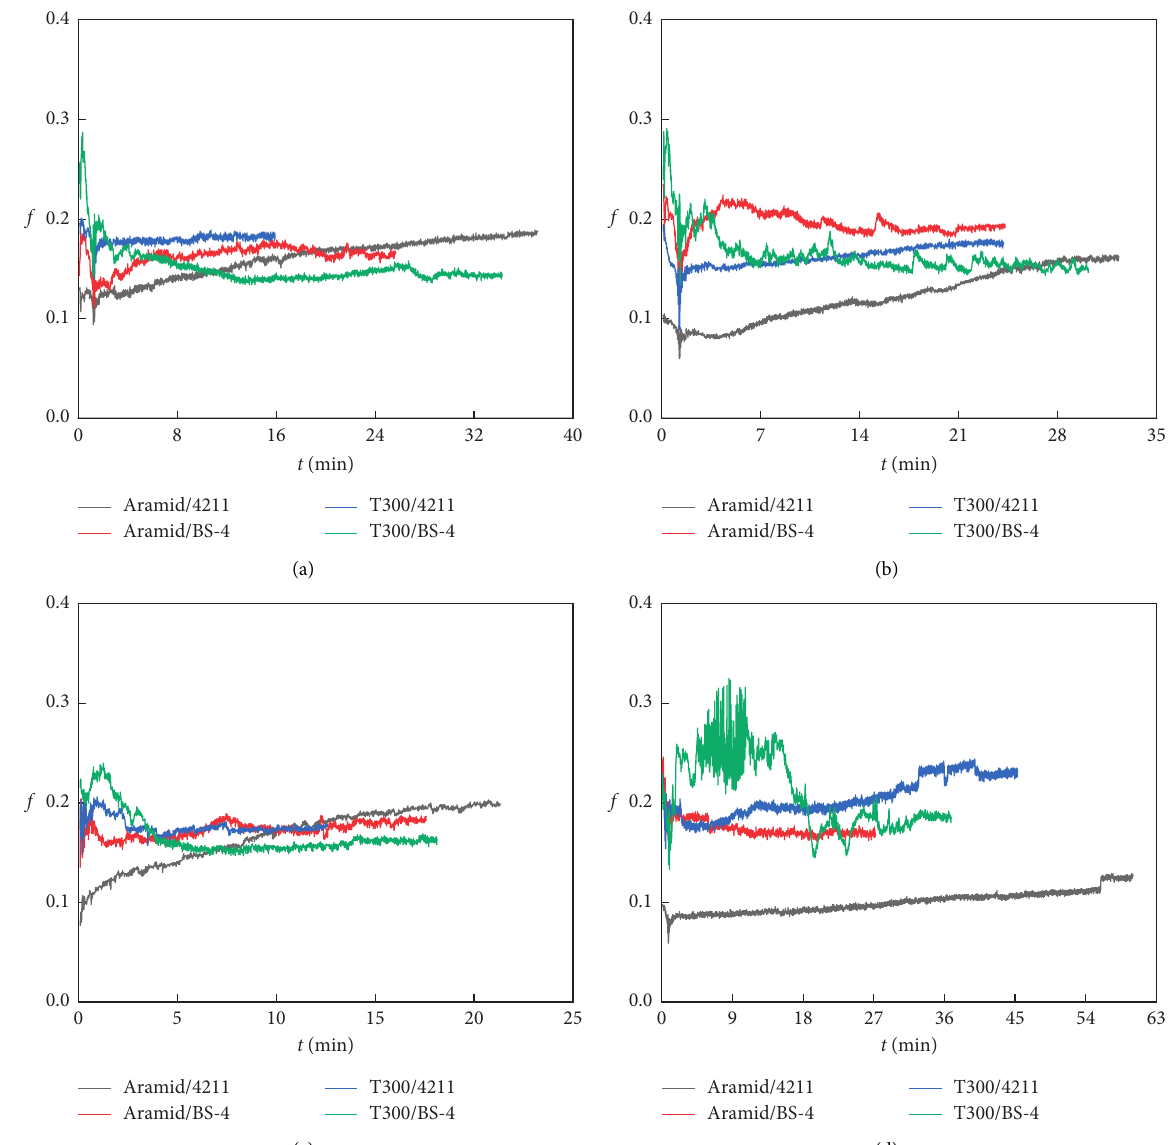
Figure 7: Friction coefficient of the composites paired with brass pins and sliding blocks under (a) 50N, (b) 75N, (c, d)